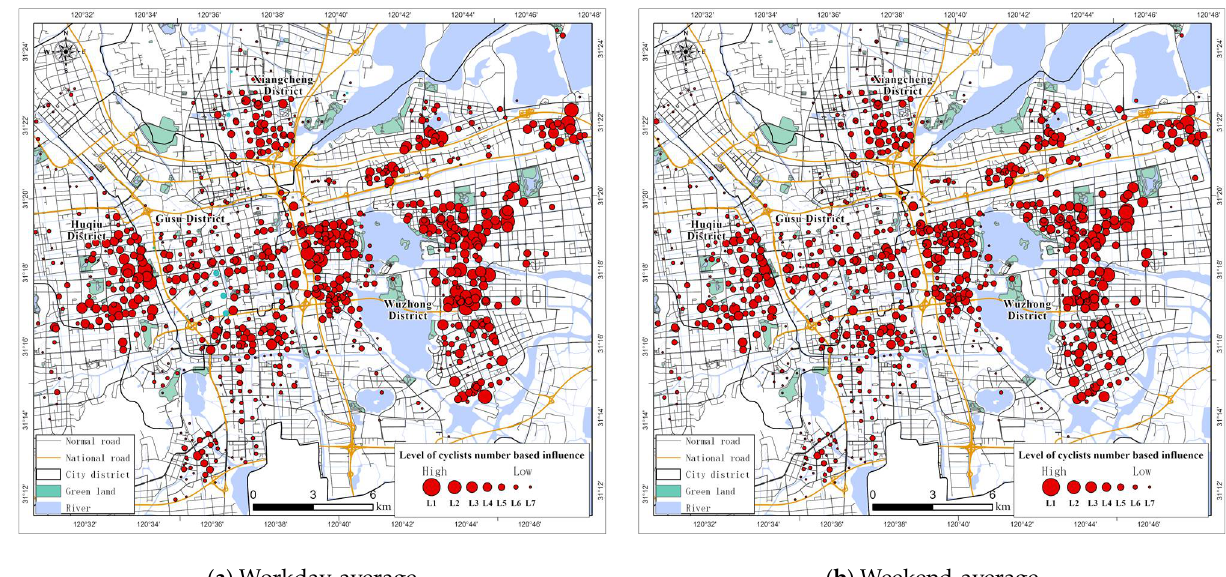
Figure 7. Cyclists number-based impact analysis result.